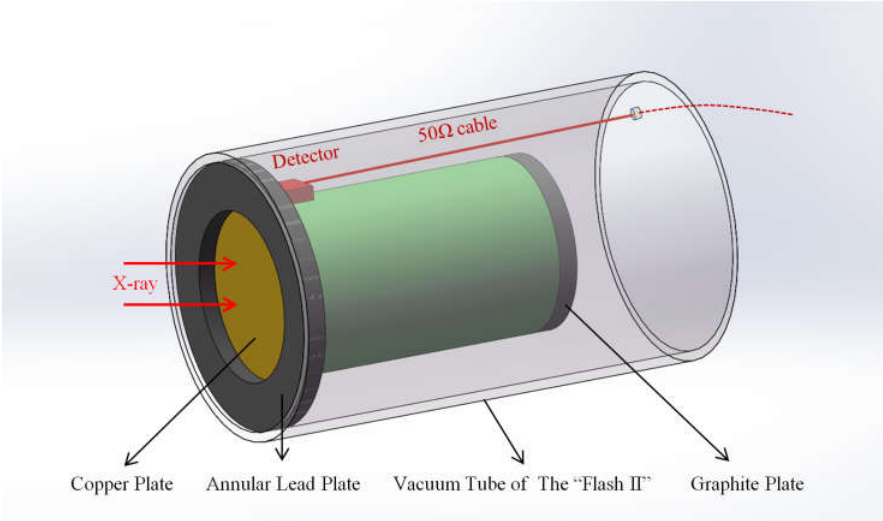
Figure 10. Measurement scheme for the magnetic field signal of the SGEMP.